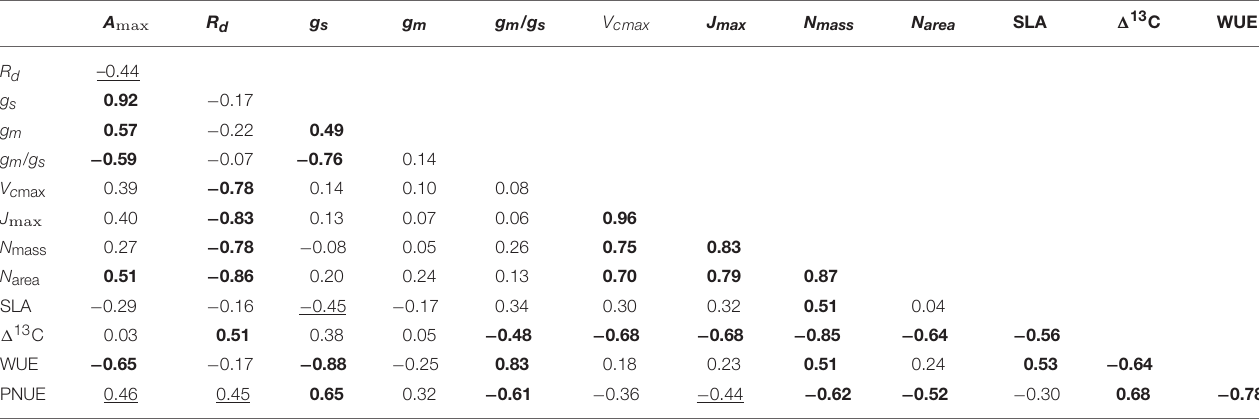
TABLE 4 | Pearson correlations ( r ) a among seed source mean values per plantation site for functional traits ( n = 18 ). A max